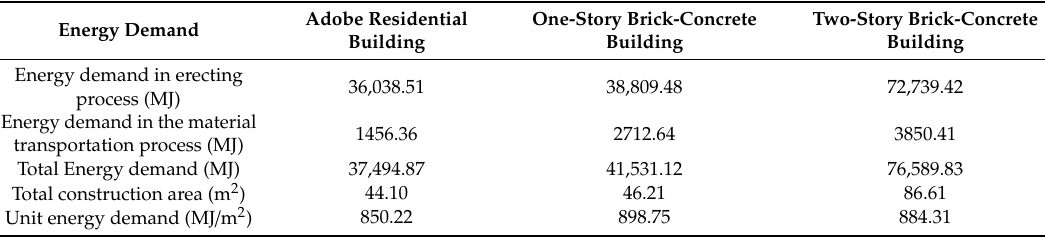
Table 7. Energy demand in building erecting of di ff erent residential buildings